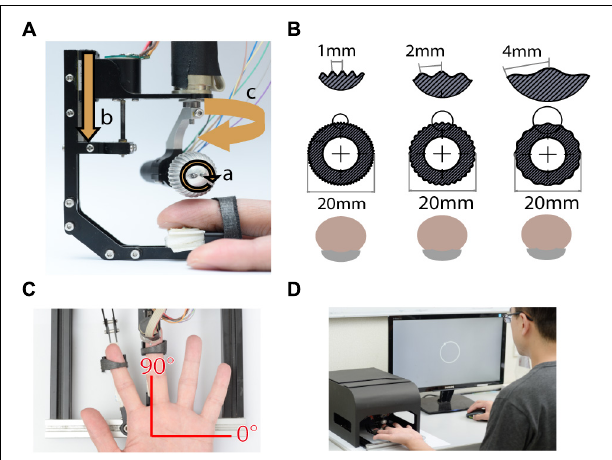
FIGURE 1 | Experimental apparatus. (A) The miniature tactile stimulator with three motors, each of which controls one degree of freedom, including (a) rotation speed, (b) indentation depth, and (c) moving direction of the ball. (B) Three grating balls, with spatial periods of 1, 2, and 4 mm. The fingerpad was positioned palmar side up. (C) Motion stimuli were delivered to the fingerpad of the left middle finger via the stimulator. The red axes show the coordinates used for stimulus presentation and participant report. (D) For each trial, the motion stimulus was delivered for 1 s, and then the participant reported the perceived direction of motion by clicking the mouse on a circle on the computer display. During the experiment, the stimulator was housed inside a specially designed case, such that the participant could not see the tactile